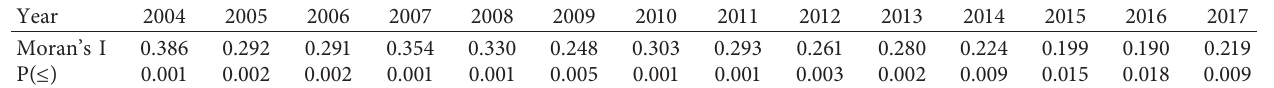
Table 3: Global Moran’ I index results.